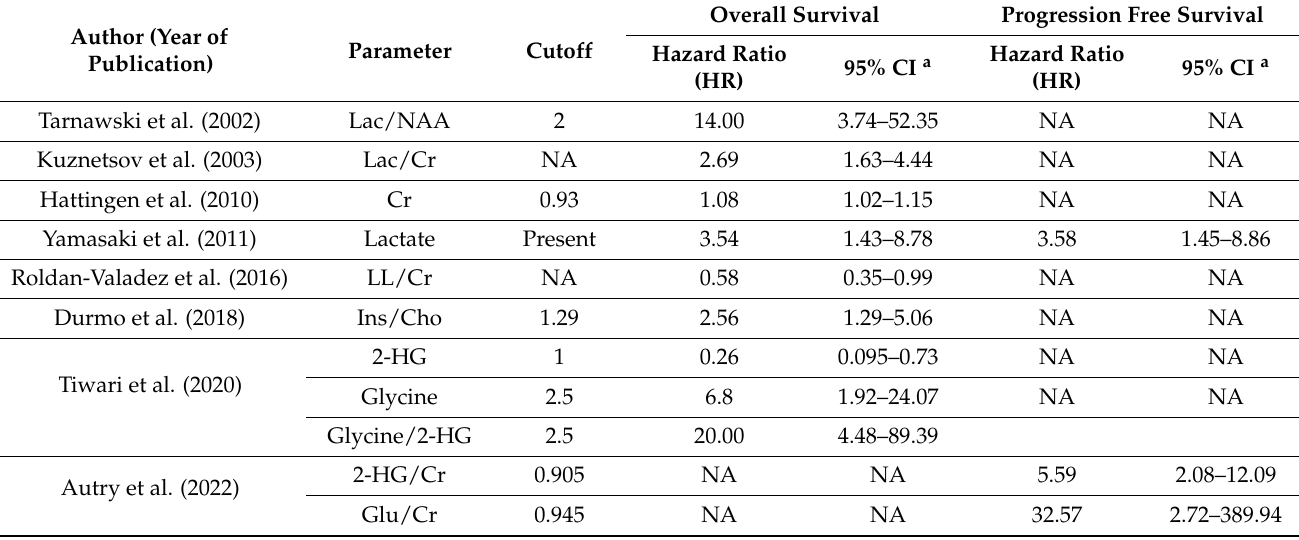
Table 3. Other metabolite parameters in the selected